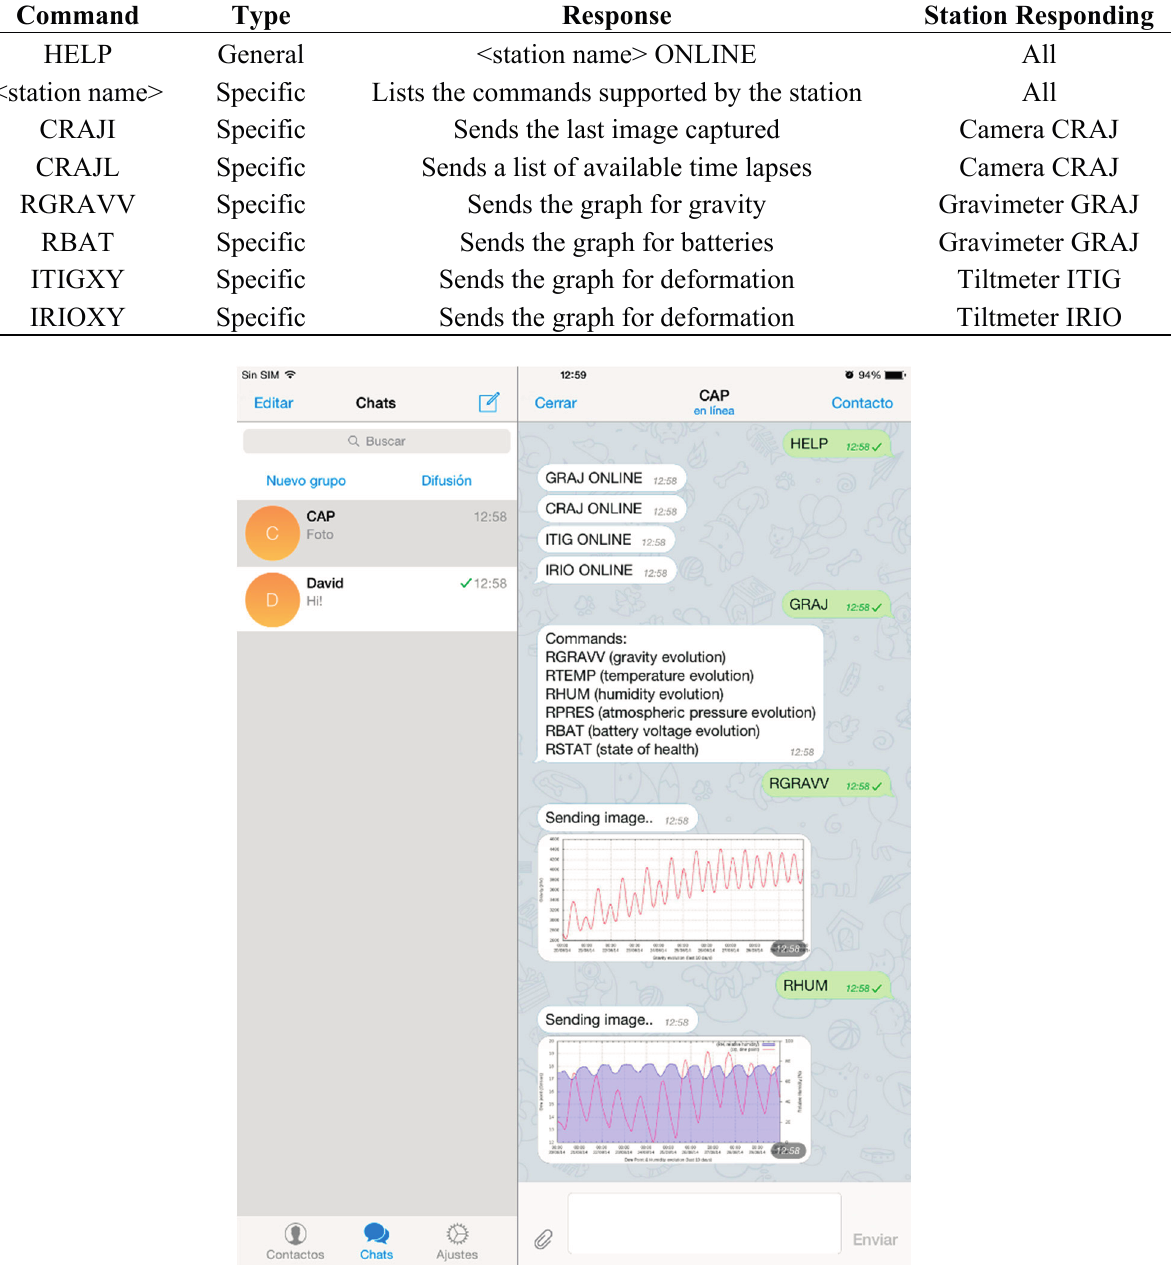
Figure 7. Querying data from various stations in real time via the Telegram instant messaging application. First, the status of the stations is requested by the general command HELP and then the station to be accessed—in this case GRAJ—is specified. After receiving this command, the station will reply with the rest of the available commands supported by the station. In this example, the graph of gravity and humidity for the previous ten days has been